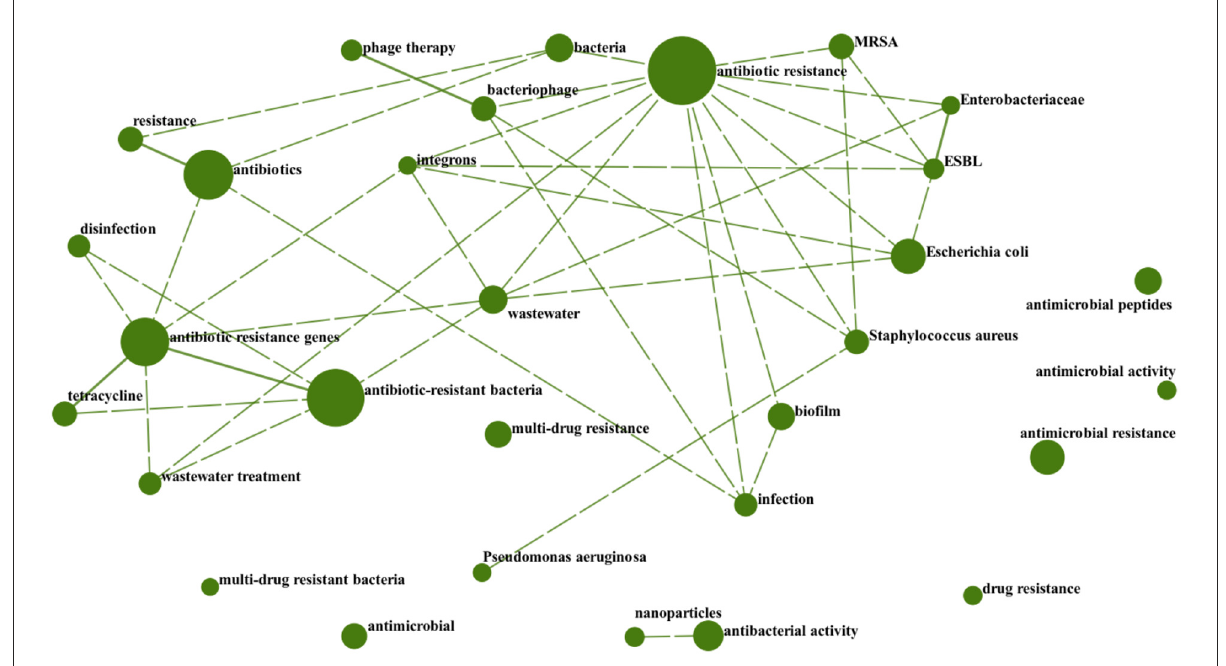
FIGURE7 Cross-correlation graph of the top 30 author keywords.